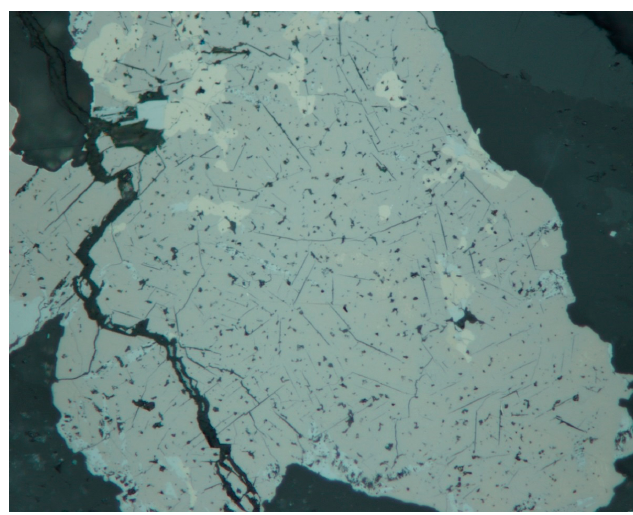
Figure 23. Brown chaméanite aggregate with grey giraudite and light brown eskebornite inclusions in the association. Reflected light, one polarizer. FOV 210 μ m. P ř íbram, a dump of shaft 16. Photo by P. Škácha.